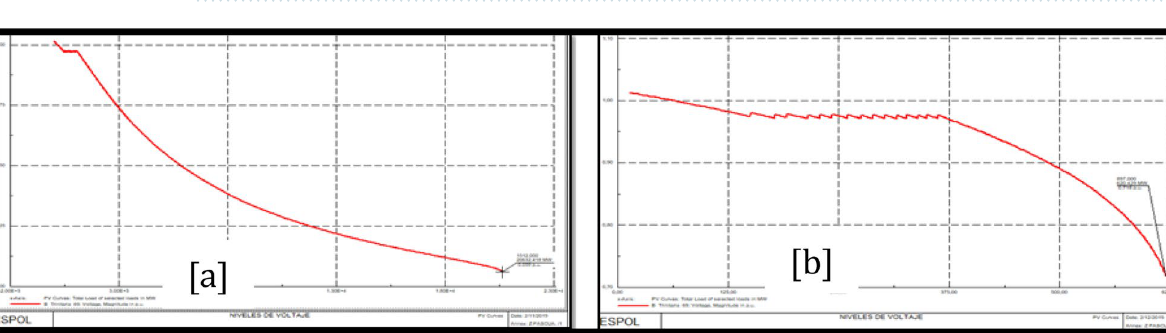
Figure 12. Stability PV before load model ( a ) and PV after load model ( b ) Nueva Prosperina 69 kV